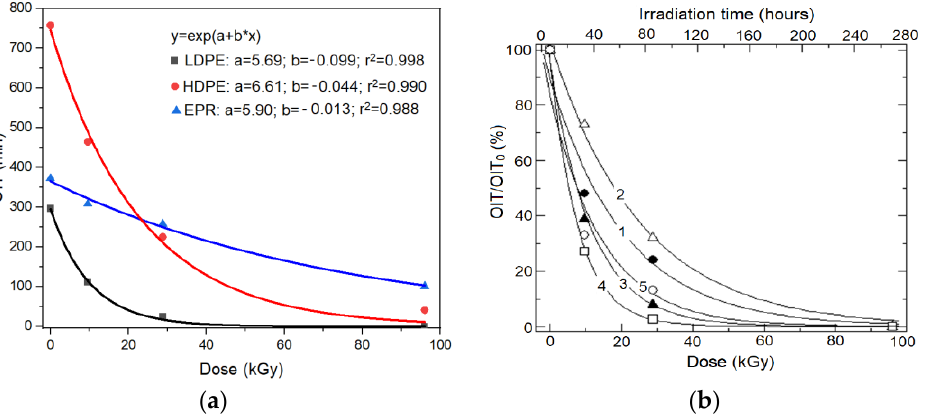
Figure 2. ( a ) Typical exponential decrease in OIT values with irradiation dose. OIT values were isothermally recorded at 190 °C (LDPE) and 200 °C (HDPE and EPR). ( b ) Decay of the normalized OIT values (OIT D /OIT 0 ; D = the radiation dose) vs. γ -irradiation dose ( 137 Cs, D r = 0.4 kGy/h) for different LDPE insulation materials: 1 — C1 * cable (irradiated as strap; Figure S1); 2 — C4 cable (irradiated as bulk; Figure S2); 3 — C3 cable (irradiated as strap; Figure S3); 4 — C9 cable, white insulation (irradiated as bulk-encapsulated; Figure S4), 5 — C9 cable, white insulation (irradiated as bulk-free ends, Figure S4); * laboratory codes.